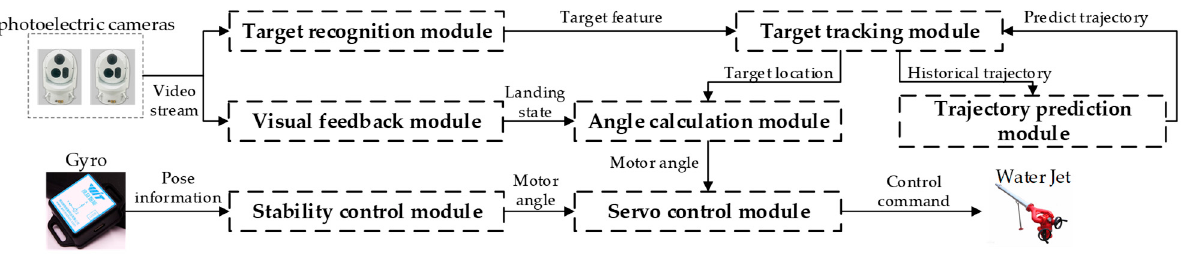
the physical platform.